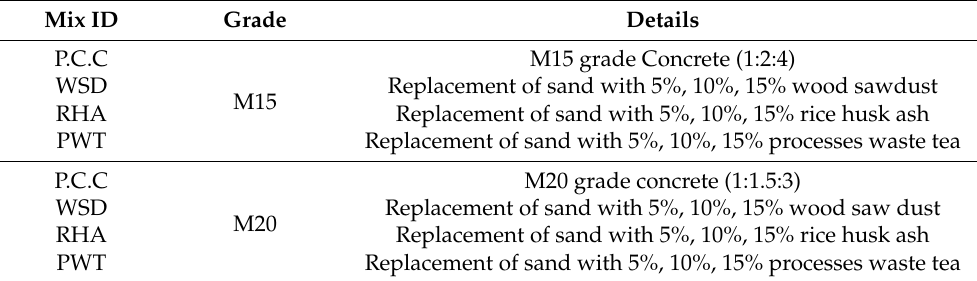
Table 3. Mix proportion of sustainable M15 and M20 grade